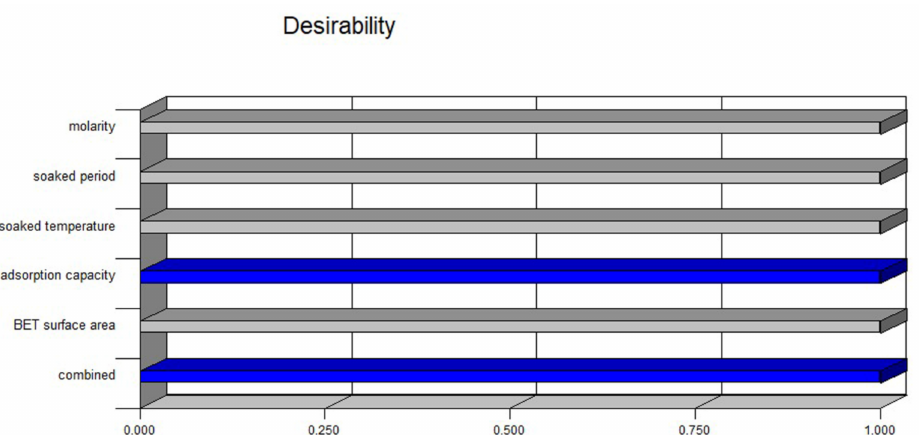
Figure 9. Individual and combined desirability functions.